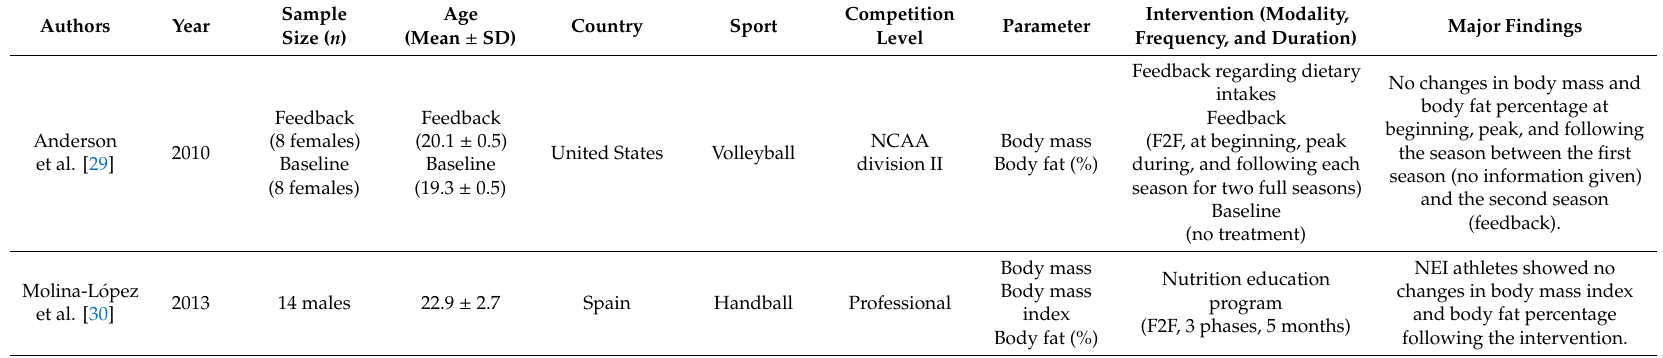
Table 3. Characteristics and major findings of the studies analyzing the e ff ect of nutrition education interventions on body composition in team sport